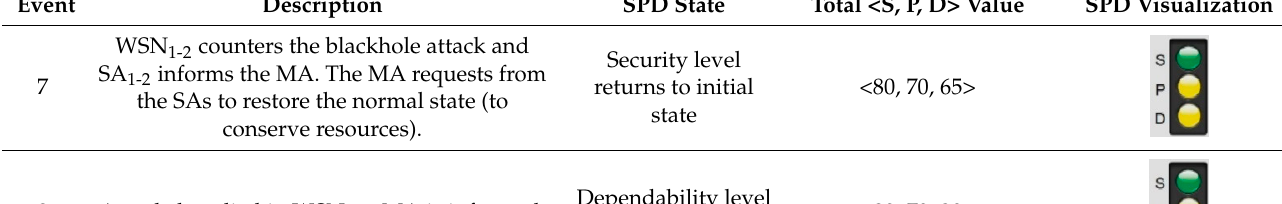
Start of all components and services. Discovery/registration operations.